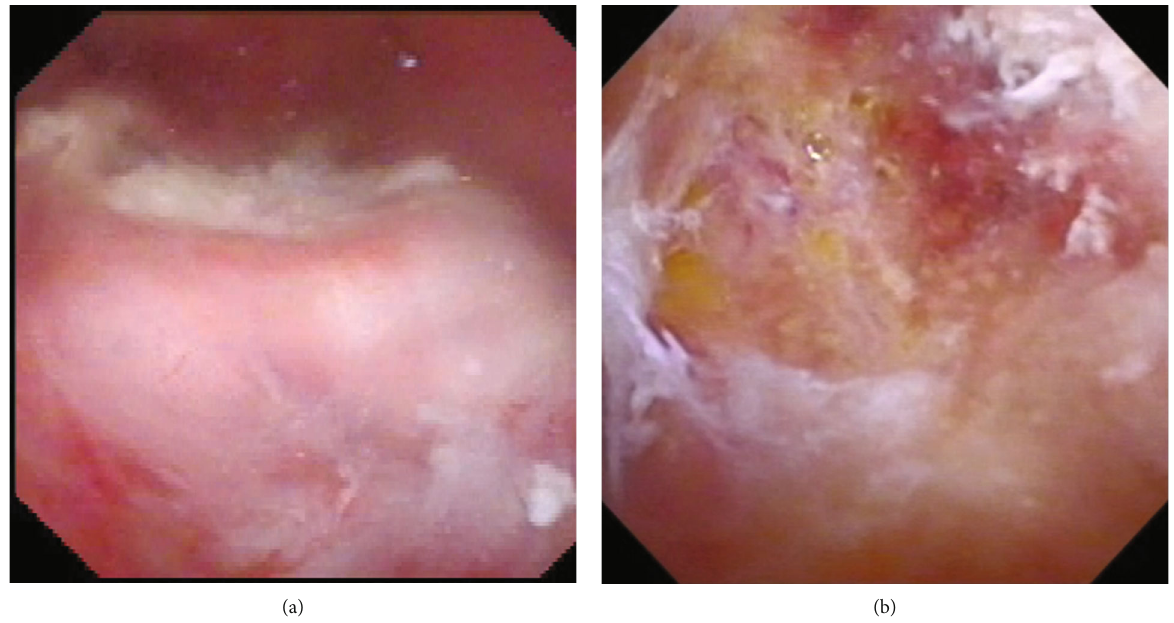
Figure 2: (a) Intravesical endoscopic imaging revealed an elevated nodule with whitish tissue and calci fi cation on the surface. (b) Removal of the calci fi cation exposed fat droplets on the bottom of the